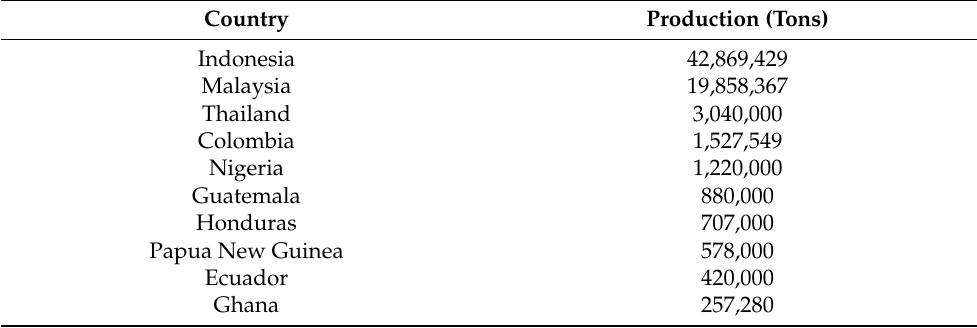
Table 1. World palm oil production countries (2019) (Source: Our World in Data).